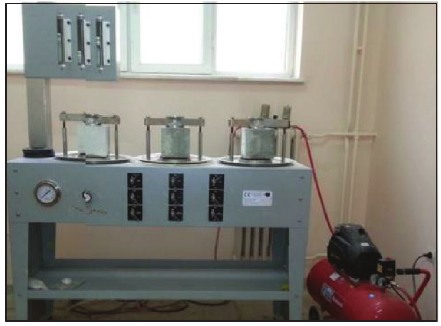
Figure 5: Water permeability test